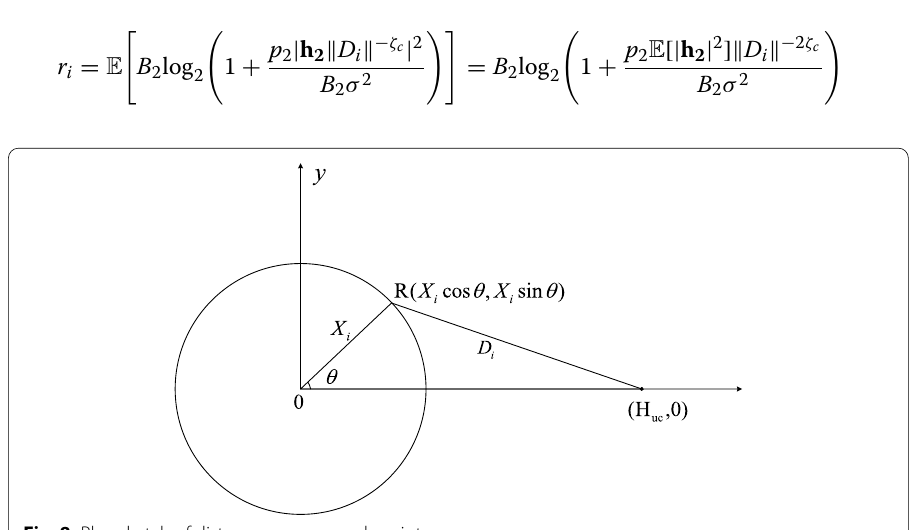
Fig. 8 Plan sketch of distances among each